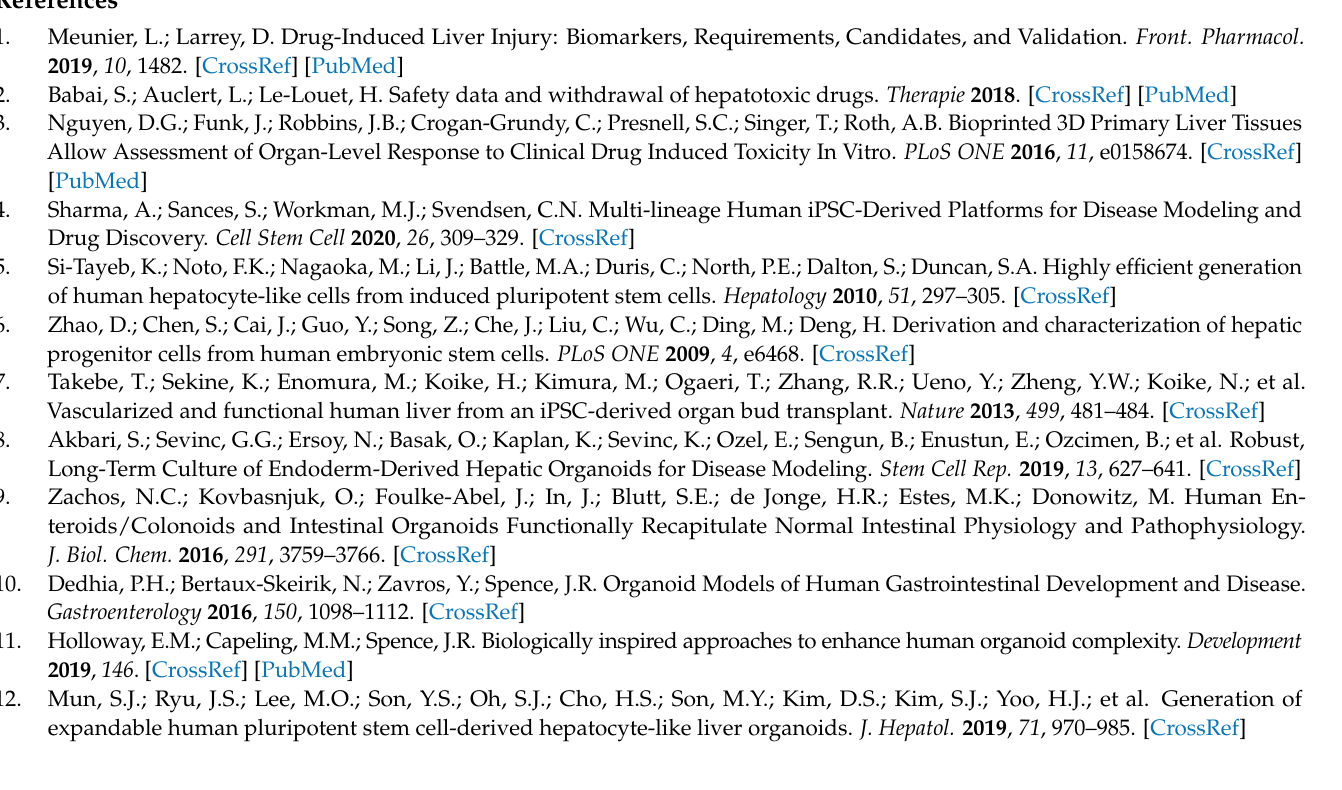
Figure S3: Effects of SCFA mixture on CMC-hiPSC-003-derived liver organoids, Figure S4: Effects of SCFA mixture on ALB expression and cell viability, Figure S5: Schedule of the optimization of liver organoid differentiation, Figure S6: Effects of SCFAs on the cell viability of CRL-2097-derived liver organoids and CYP3A4-mediated drug toxicity in CMC-hiPSC-003-derived liver organoids, Figure S7: Effects of SCFA mixture on PHHs and HepG2 cells, Table S1: Primer sequences used in this study, Table S2: Antibodies used in this